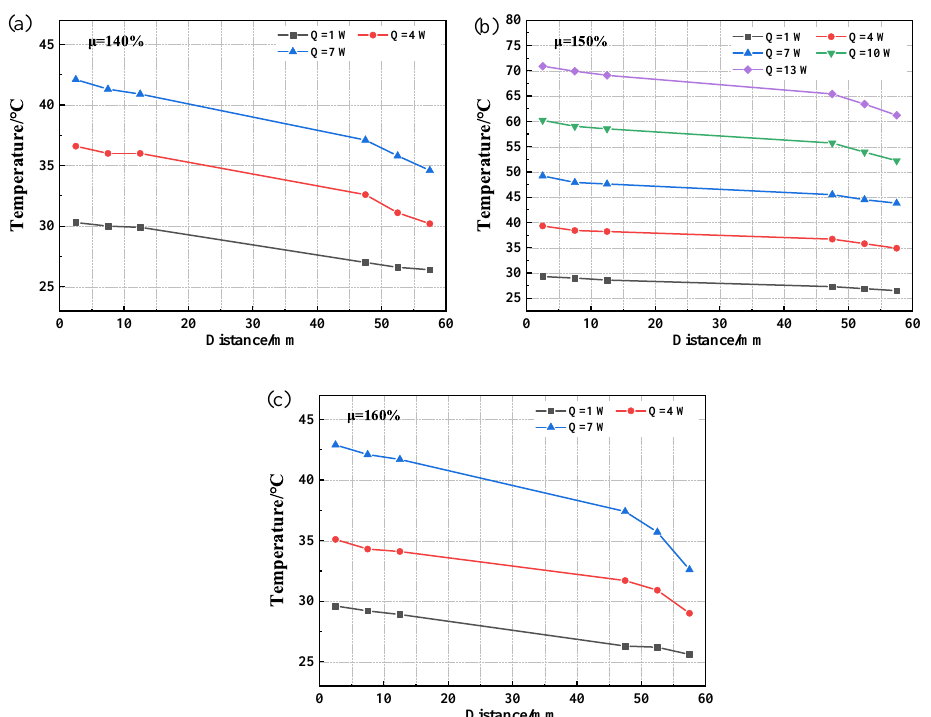
Figure 11. Axial temperature distribution of CFW-FMHP under different thermal power. ( a ) 140% filling rate; ( b ) 150% filling rate; ( c ) 160% filling rate.